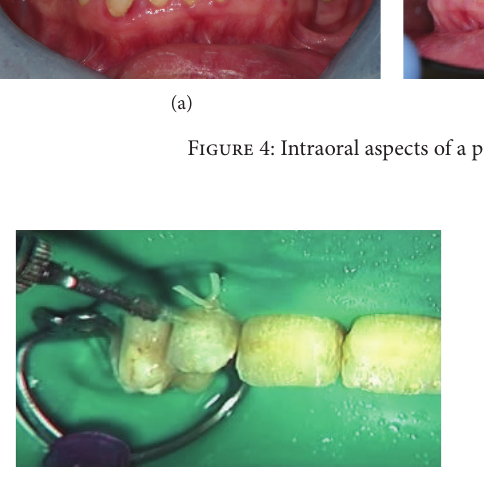
Figure 5: Treatment of the damaged enamel with Er:Yag laser.